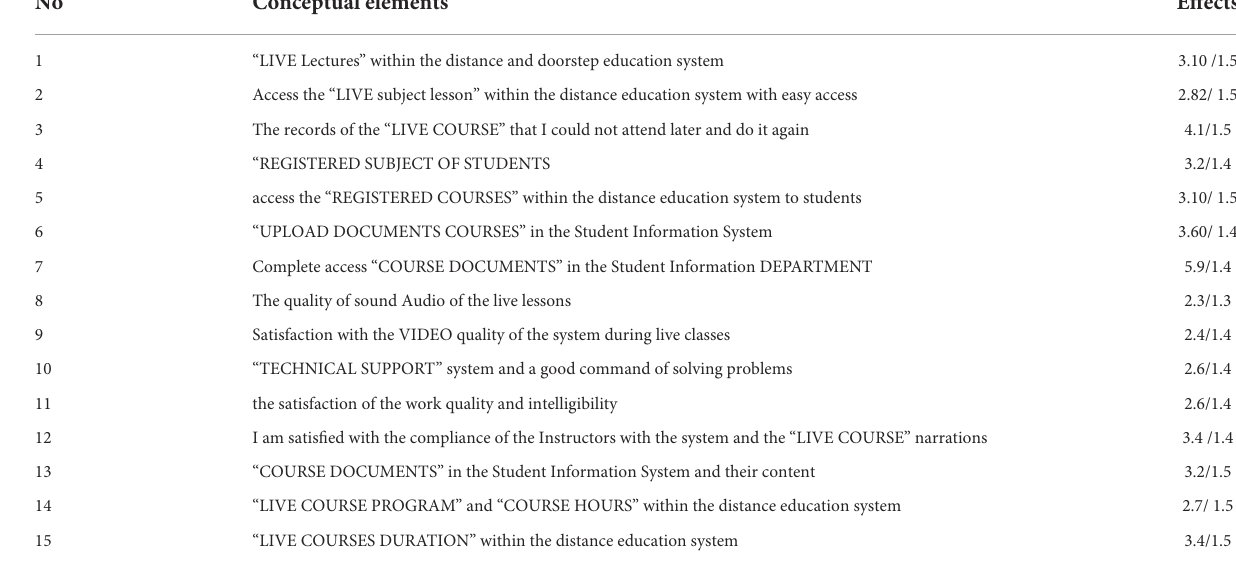
TABLE 5 Universities and all higher education systems and faculties are uploading courseware to student information